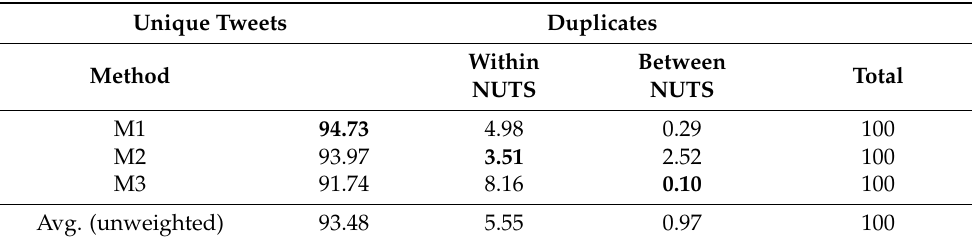
Table 1. Unique tweet and duplicates by method of collection (percentage values; the best perfor- mance measures are in